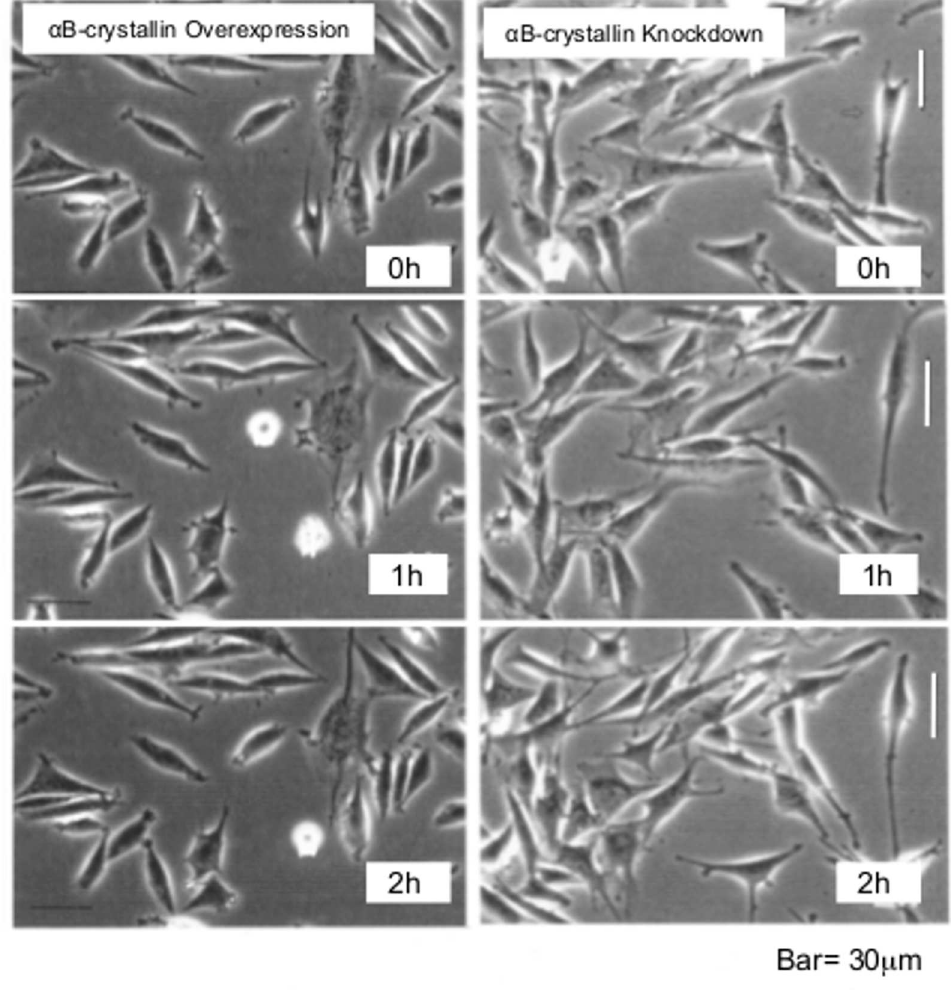
Fig 8. Time-lapse imaging. α B-crystallin-overexpressing cells (left column), and knockdown (right column)L6 cells at 0 h, 1 h, and 2 h time points. Bar is 30 μ